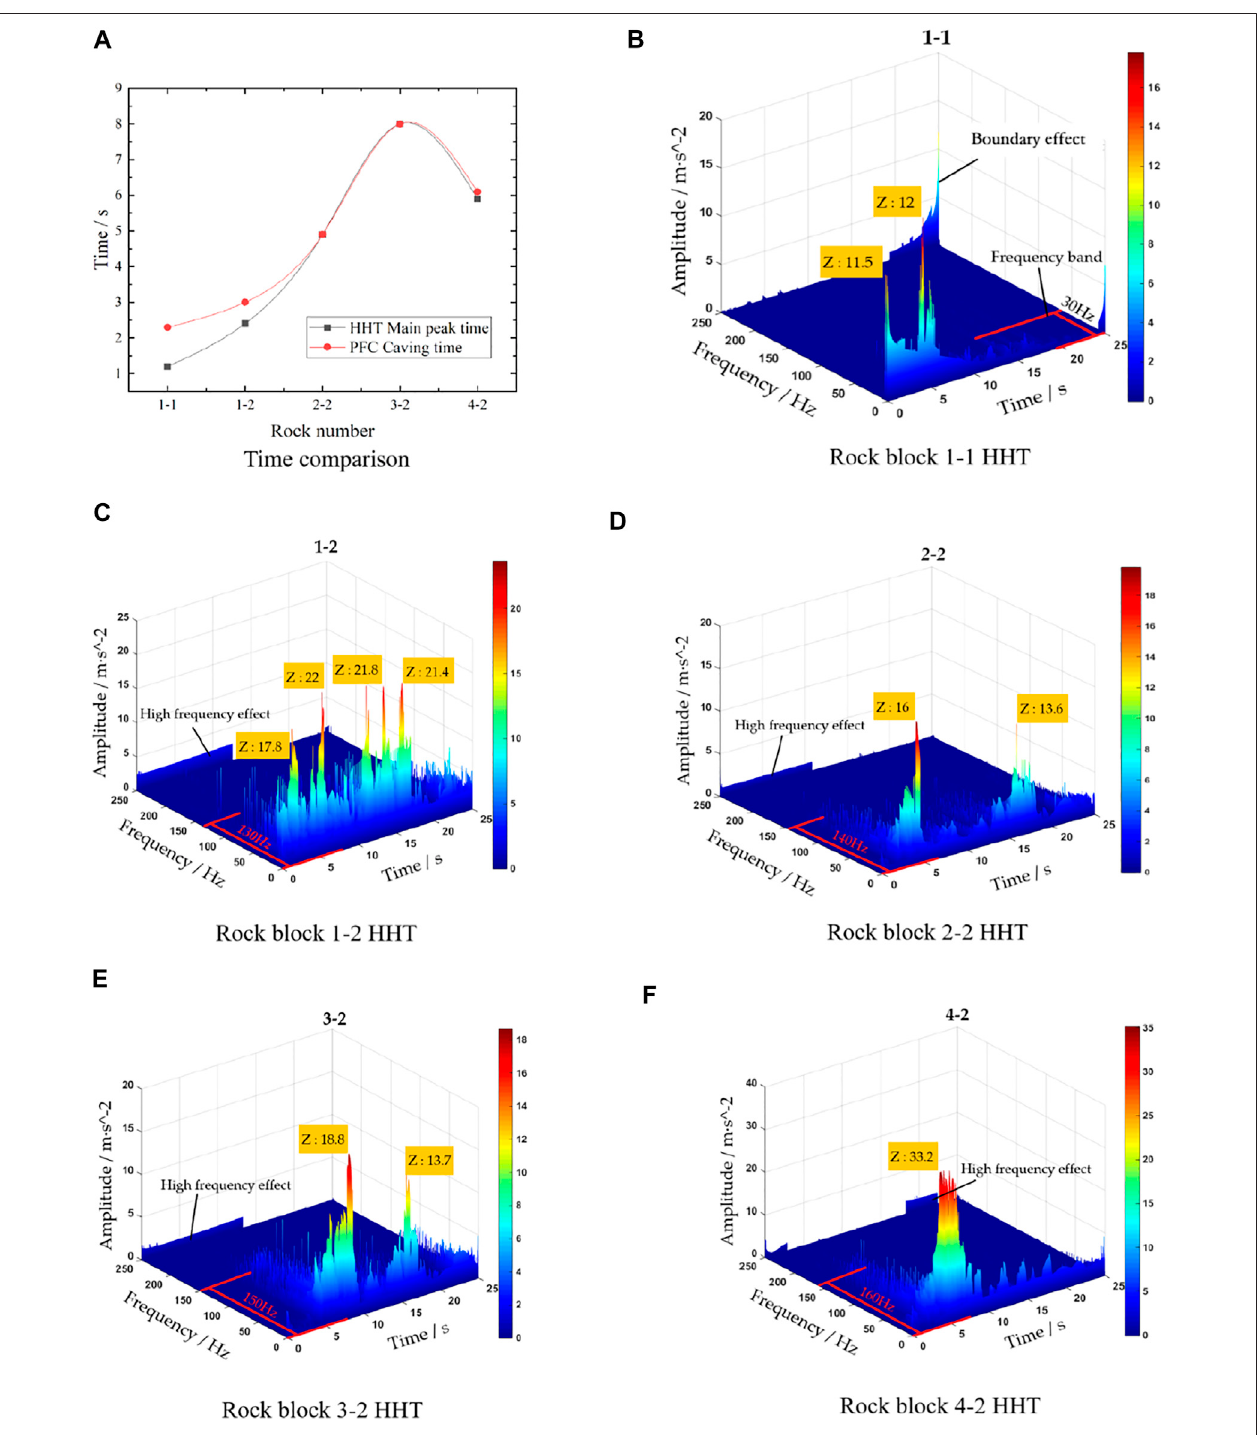
FIGURE 11 | HHT Time-frequency